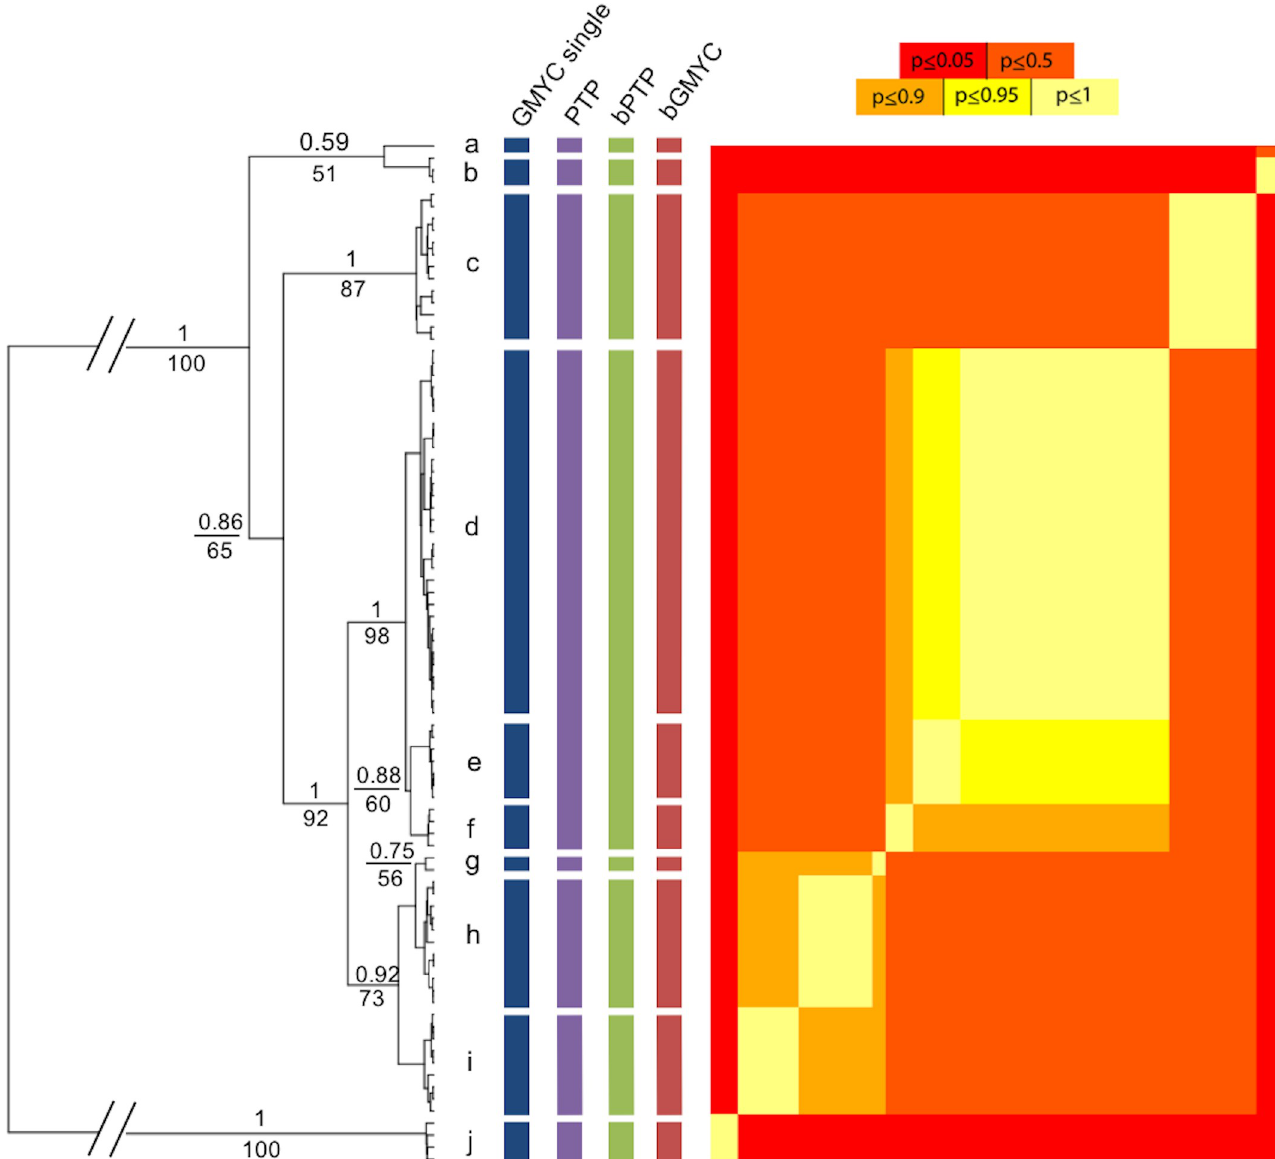
Fig 2. To the left is the maximum clade credibility tree from the Bayesian analyses based on cytochrome oxidase subunit 1 (COI) sequences with results of the single threshold GMYC model (blue vertical lines), bGMYC (red vertical lines), PTP (purple vertical lines) and bPTP (green vertical lines). Values above tree branches are Bayesian posterior probabilities/maximum likelihood bootstrap values. To the right the heat-map represents a sequence-by-sequence matrix where cells are coloured by the posterior probability that the corresponding sequences are conspecific, allowing for the visualisation of uncertainty in species limits returned by the bGMYC method. The letters correspond to clades a = Mytilus californianus from USA (Monterrey Bay); b = Mytilus coruscus from China (Zhouhan); c = Mytilus trossulus from USA (Damariscotta and Penn Cove) and Canada (Mahome Bay and Bras d’Or Lake); d = Mytilus chilensis from Chile (Maullı´n, Quillaipe Puerto Saavedra, Caleta Pescadores, Huildad, Estero Fanny, Isla London, Chaihuı´n, San Gregorio and Puerto Cisne), Argentina (Mar del Plata and Punta Pe ñ a), Uruguay (Punta del Este) and Kerguelen island; e = Mytilus spp. from Australia (Tura Head and Green Cape) and Tasmania (Cloudy Bay, Hobart, Simpson’s Bay and Snug); f = Mytilus spp. from New Zealand (Auckland Islands, Dunedin and Wellington), g = Mytilus spp from N/A and Finland (Hanko); h = Mytilus galloprovincialis from Italy (Chioggia), Greece (Samos), Australia (Green Cape, Nedlands, Tura Head), South Africa (Paternoster), Chile (Dichato, Lota); i = Mytilus edulis from Sweden (Tja´rno), USA (Beaufort), Canada (Antigonish), Argentina (Punta Cueva) and the Falkland Islands (Bense Island); j = outgroup Choromytilus chorus from Chile (Colu´n).